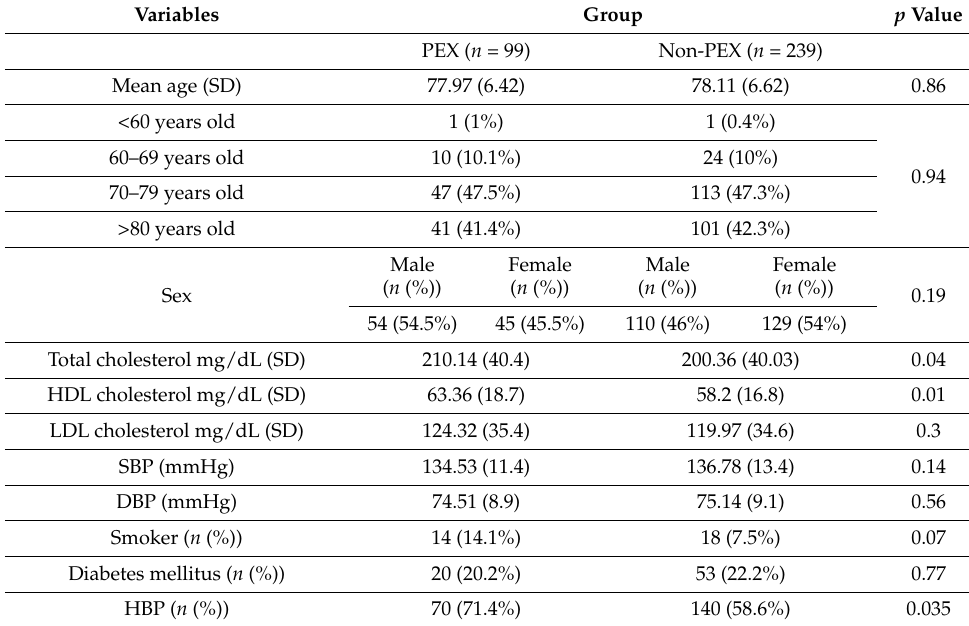
Table 2. Distribution of the PEX and Non-PEX cohorts by CVR